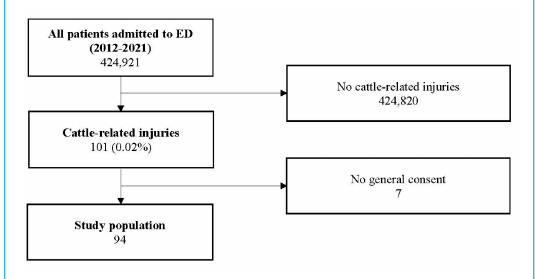
Figure 1: Patient flowchart. ED: emergency